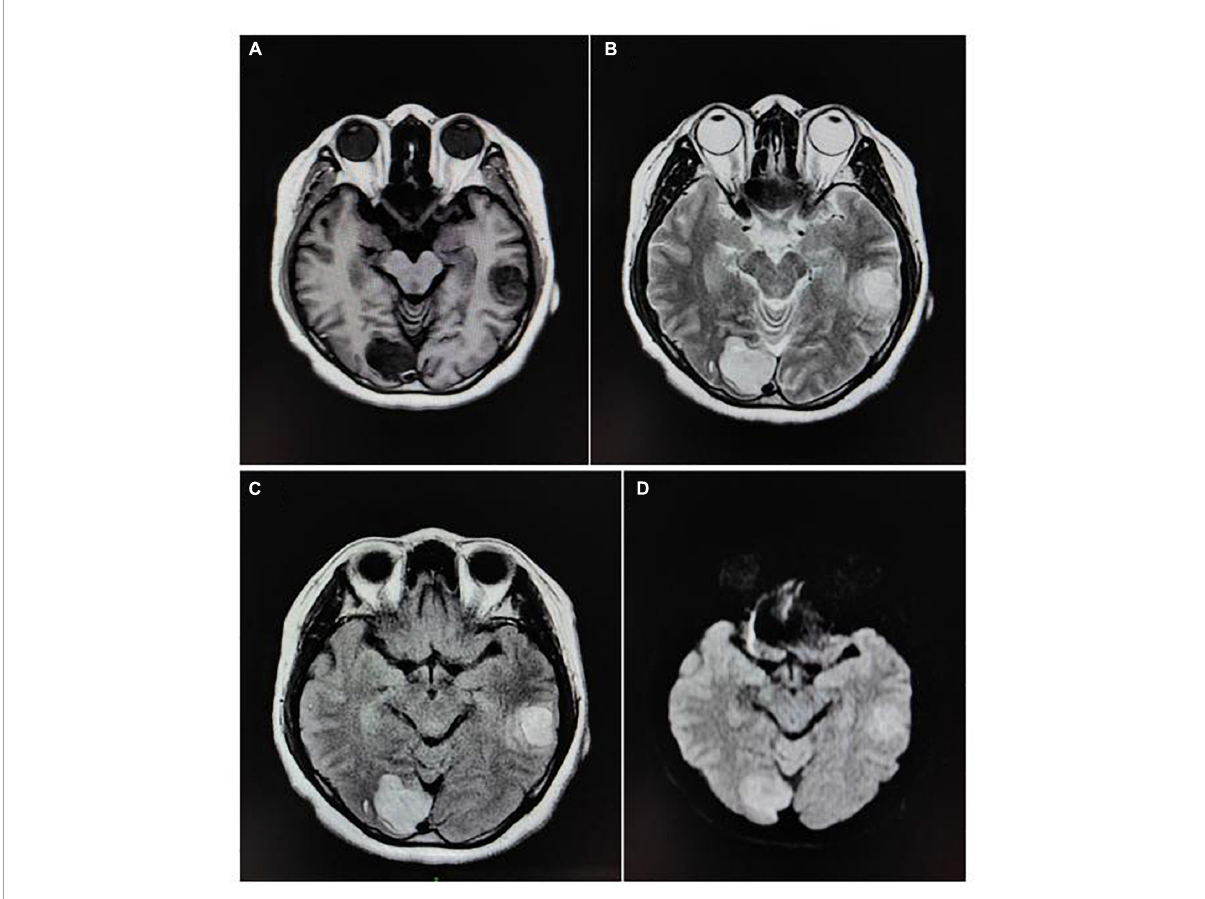
FIGURE2 MRI results of MTB. The patient, a 57-year-old woman, presented with MTB in the left temporal lobe and right occipital lobe. The primary tumor was lung cancer, single and irregular. (A) Transverse T1WI. (B) Transverse T2WI. (C) Transverse T2 FLAIR. (D) Transverse